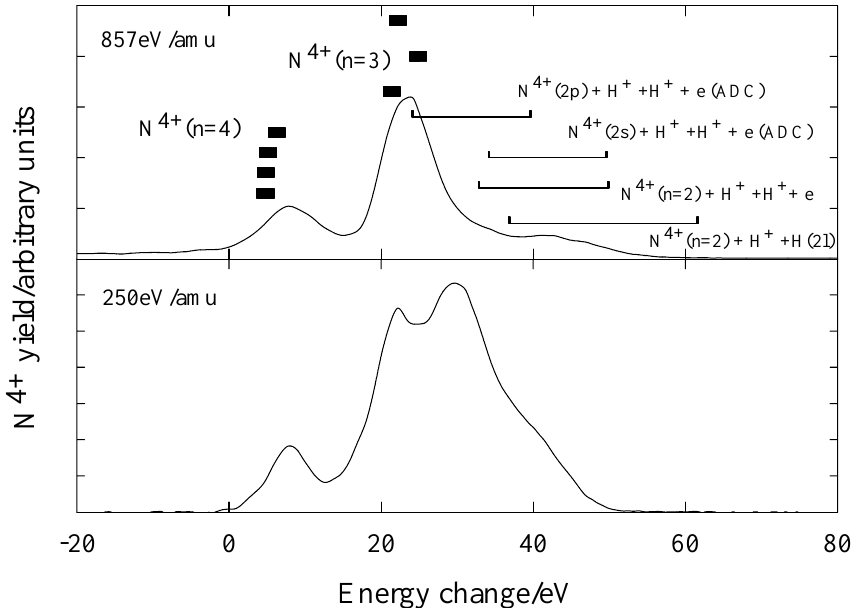
at energies of 857 eV/amu and 2